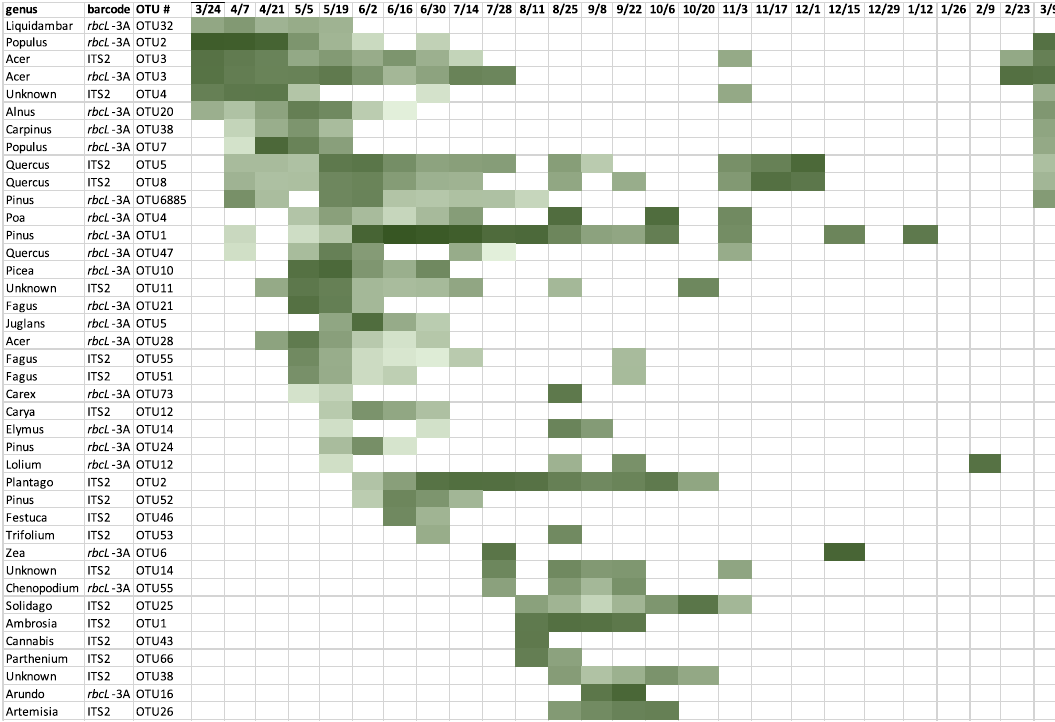
Figure 3. Heat map of the 40 most abundant OTUs found in 14-day dust samples collected in Lexington, MA. The OTU number, barcode used, and assigned genus according to NCBI Genbank are listed, as is the relative abundance in the sample collected on the date indicated. The shade of color indicates the number of reads from a minimum of 10 (light green) to roughly 50,000 (dark